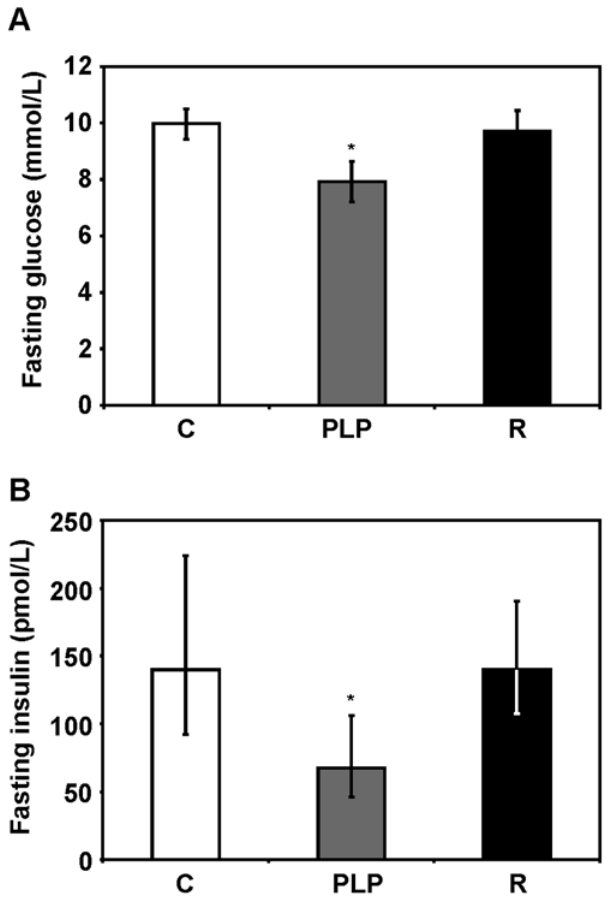
Figure 3. Fasting glucose and insulin concentrations. (A) Fasting blood glucose was measured using a blood glucose analyzer (Hemocue, Angelholm, Sweden). Values are expressed as mean 6 SEM, * P , 0.05 compared to control (n=control (C): 10, postnatal low protein (PLP): 8, recuperated (R): 10). (B) Fasting blood insulin concentrations were measured using a mouse insulin ELISA kit (Mercodia Ultra-sensitive Mouse Insulin ELISA, Mercodia, Uppsala, Sweden). Values are expressed as geometric mean (95% confidence intervals) and was log transformed prior to analysis. * P , 0.05 compared to control (n=C: 10, PLP: 8, R: 10). doi:10.1371/journal.pone.0004950.g003 relative weights of brain and thymus in PLP were significantly higher than controls (Figure 2C). In recuperated animals the relative weights of pancreas, kidneys and liver were lower than controls, however the relative weights of spleen, heart, lung and thymus showed no difference as compared to controls (Figure 2C).